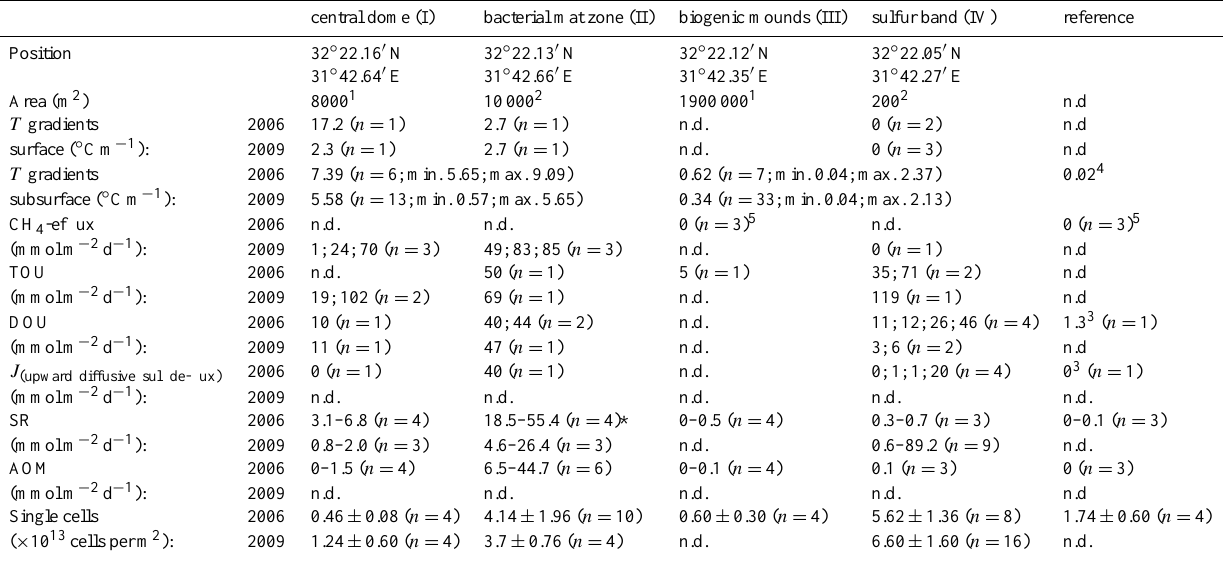
Table 1. Overview of data from the four main Amon MV habitats. Surface and subsurface T gradients were measured in situ with microsensor and T-lance measurements, respectively. Methane efflux and total oxygen uptake (TOU) was measured with the benthic chamber. The dissolved oxygen uptake (DOU), and upward diffusive sulfide flux were calculated based on in situ microsensor measurements. The averaged sulfate reduction (SR) and methane oxidation rates (AOM) were integrated over the first 15cm. Single cells determined by AODC were depth integrated over the first 2cm of the sediment. (n.d. = not determined; n = numbers of replicates if